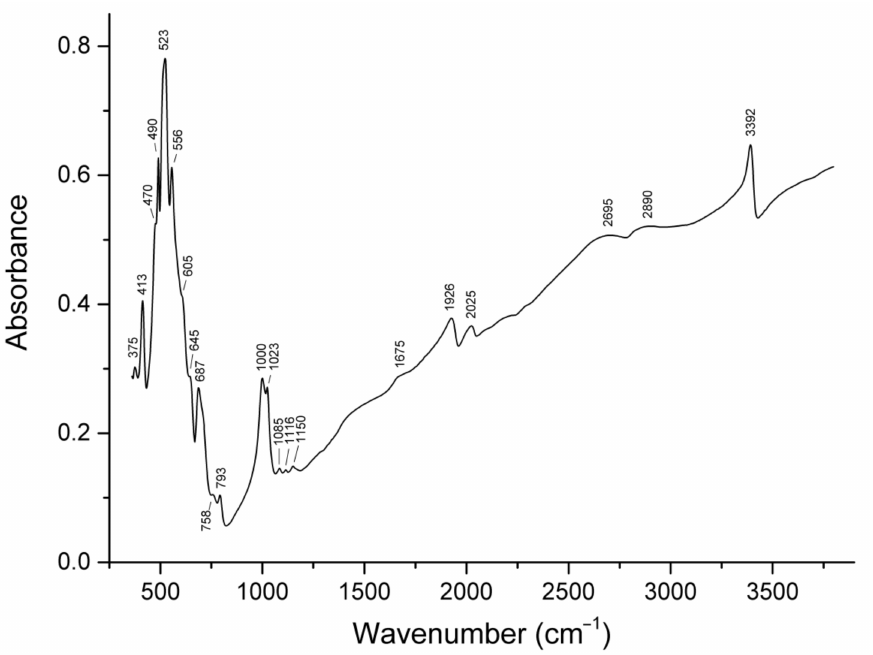
Figure 2. Infrared spectrum of two-phase (groutite + “groutellite”) pseudomorphs after ramsdellite from the Black Water mine, Arizona,